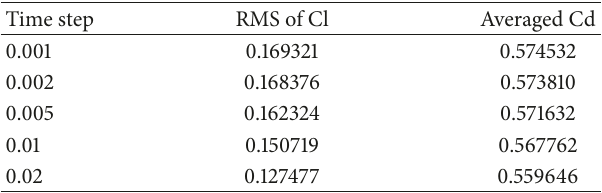
Table 4: Different time steps of the RMS of lift and averaged drag